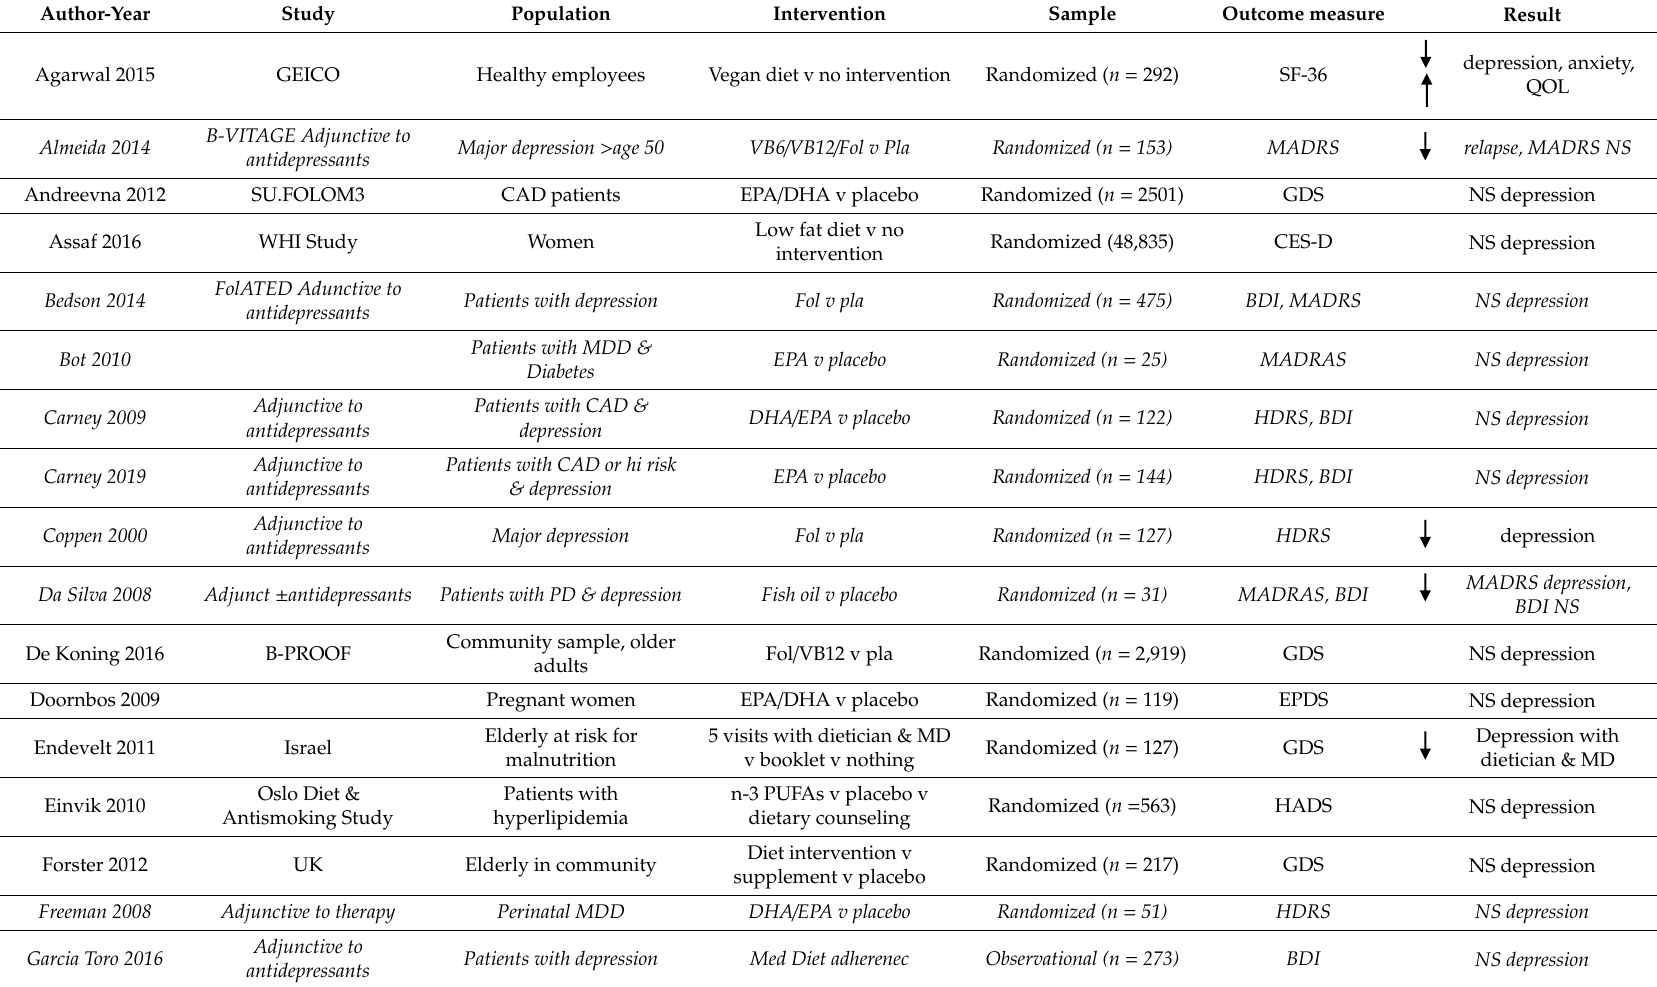
Table 1. Controlled Trials on Dietary Interventions for Depression.